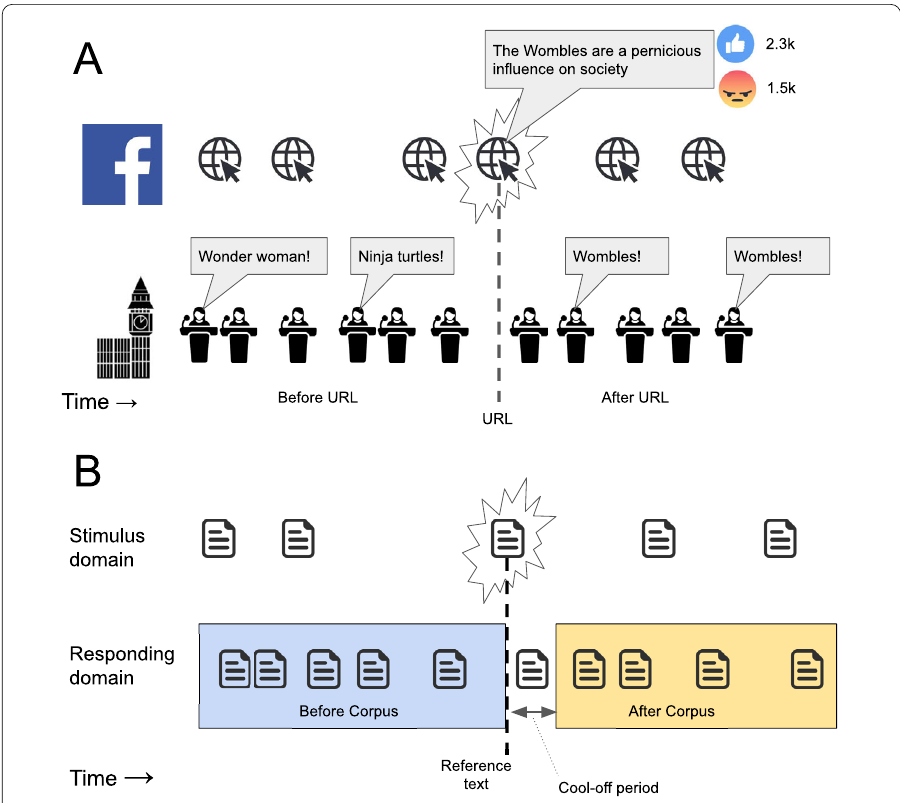
Figure 4 Diagram showing our method with a specific example (panel A) of how an Article shared on Facebook might influence Commons Speeches. Note that the news article contains the word Wombles , which then appears in the Commons speeches after the article is shared on Facebook. Panel B shows a more general method which is used to measure content flow between